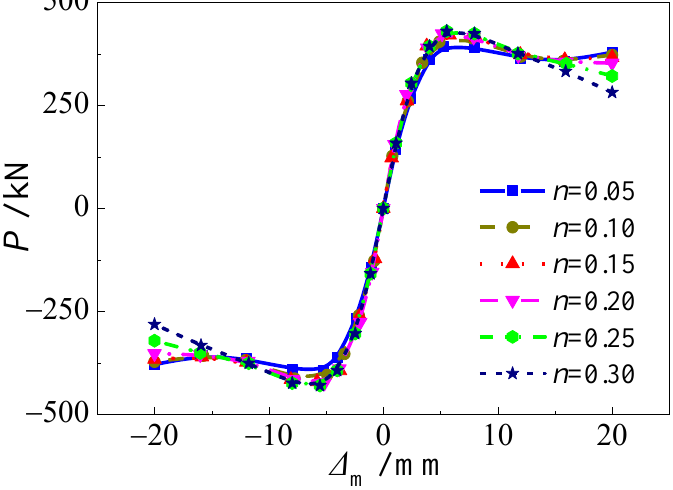
Figure 20. Effect of axial load ratio on skeleton curve. Figure 21 depicted the effects of alternation time on hysteretic curves of CFST piers under horizontal load after an alternation of sulfate corrosion and freeze-thaw cycles.